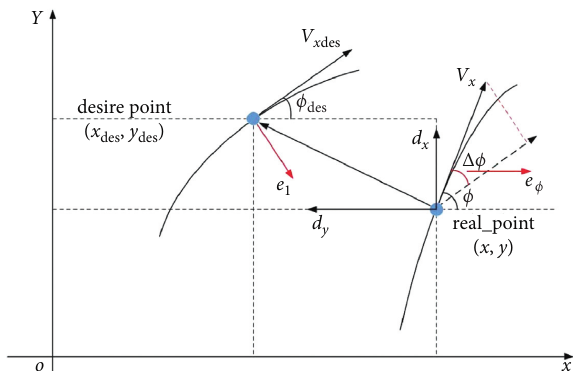
Figure 4: Schematic diagram of calculation of lateral error of driverless car.